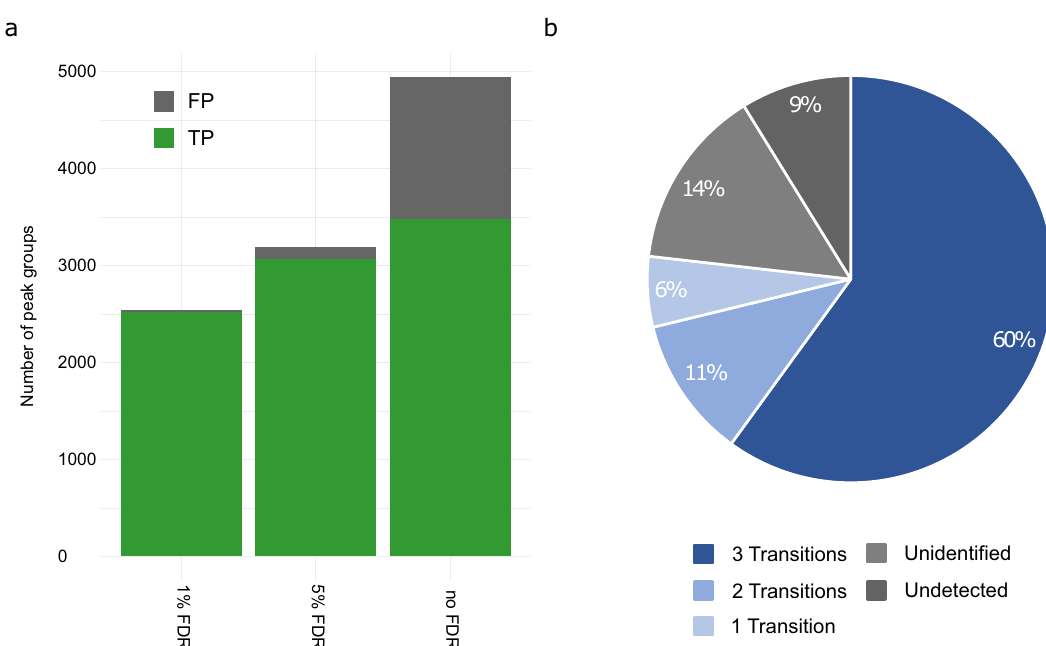
Fig. 2 FDR fi ltering and library coverage. a Peak groups detected and quanti fi ed by DIAMetAlyzer in a APM spiked-in human blood plasma dilution series (SWATH - 30 samples) fi ltered by different FDR thresholds. Without FDR fi ltering (no FDR), we detected and quanti fi ed the highest number of true positive peak groups (TP; n = 3479), but also the highest number of false positive peak groups (FP; n = 1471). At 5% FDR, 3071 true peak groups and 125 false positives were quanti fi ed (3.9%). At 1 % FDR the true positive peak groups were further reduced ( n = 2523), so were the false positives ( n = 19; 0.7%). b Individual pesticide mixes in solvent (around 30 pesticides each) were used to construct the target-decoy assay library. Stringent fi ltering allows high-quality assays to be used in library construction: Around 9% of the pesticides could not be detected in the data. An additional 14% were not identi fi ed via MS1 or did not possess a valid MS2 spectrum (4 + peaks, to allow for fragment annotation). 77% of the pesticides were automatically detected, identi fi ed, and annotated. In the library construction step, fi ltering by the number of transitions greatly affects the coverage of metabolites (three transitions: 60% coverage, two transitions: 71% coverage, one transition: 77%